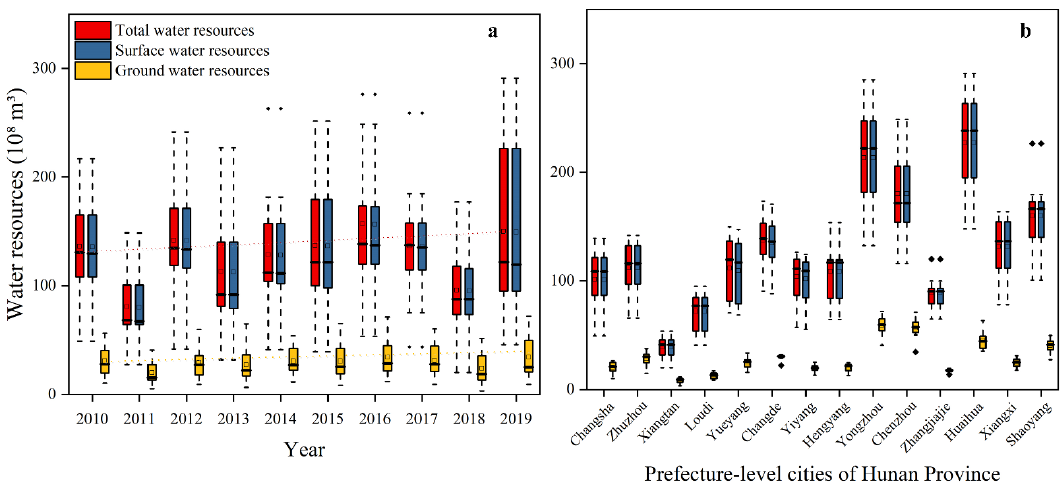
Figure 2. Temporal ( a ) and spatial ( b ) variations in total water resources, surface water resources, and groundwater resources among the 14 prefecture-level cities from 2010 to 2019. The whiskers represent the maximum and minimum values, the top and bottom of the boxes are the 25th and 75th percentiles, respectively, the median is represented by the horizontal line, and the mean by the open rectangle. The dotted lines in ( a ) are the trend lines of surface water resources in red and ground- water resources in yellow.